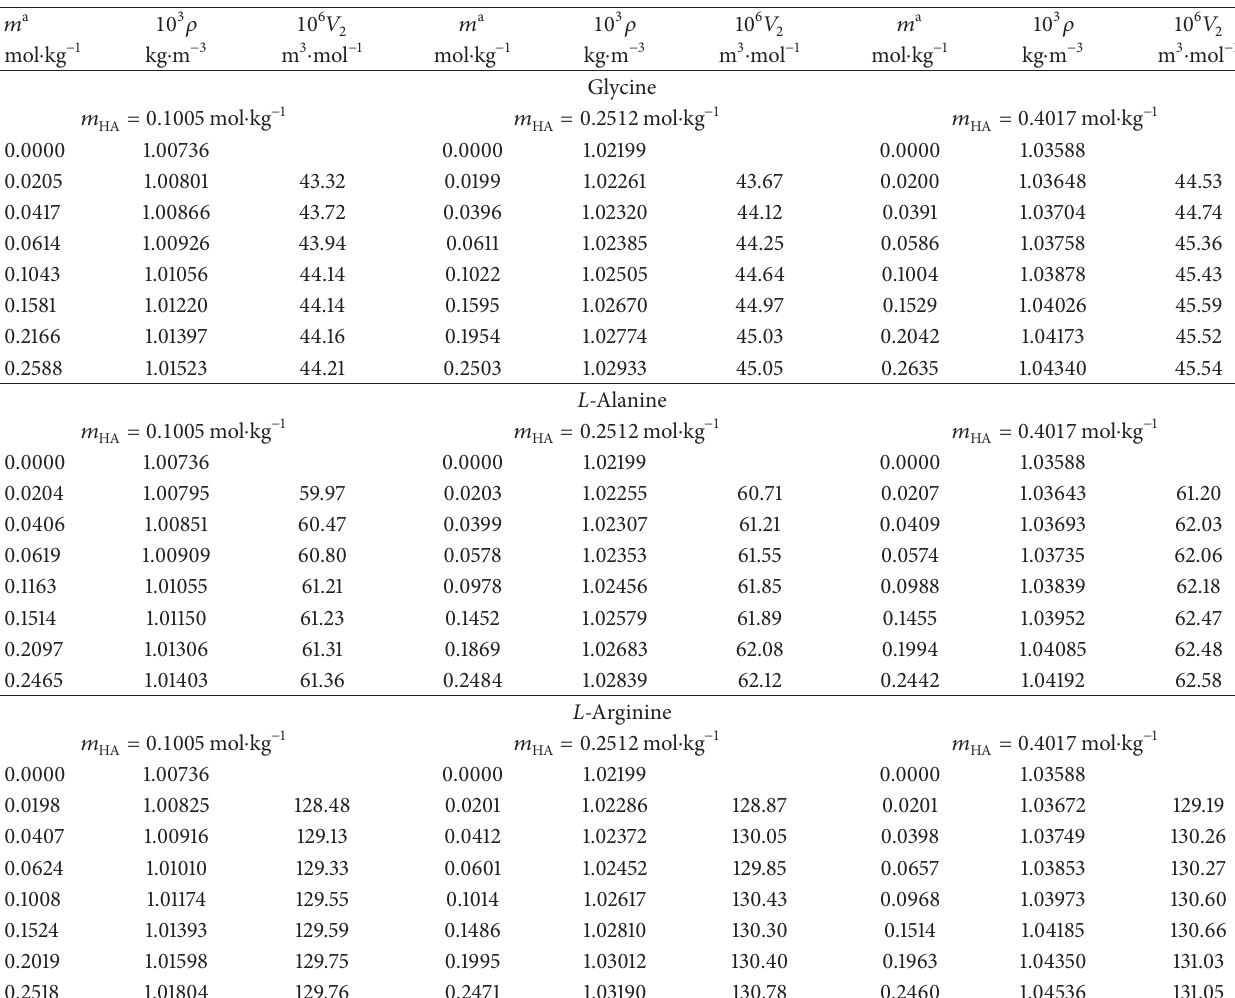
Table 2: Density, 𝜌 , and apparent molar volumes, 𝑉 2 , of amino acids in aqueous hydroxylamine sulfate solutions as a function of amino acids concentration, 𝑚 a , at T = 298.15 K